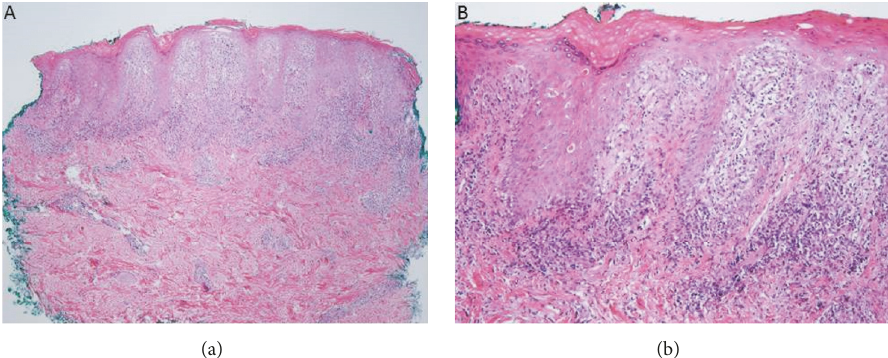
Figure 2: Hematoxylin-eosin-stained biopsy specimens from left 2nd digit. (a) Dense superficial to middermal lymphocytic infiltrate with few scattered eosinophils (40x magnification). (b) Scattered apoptotic keratinocytes within the epidermis and vacuolization at the dermal- epidermal junction (100x